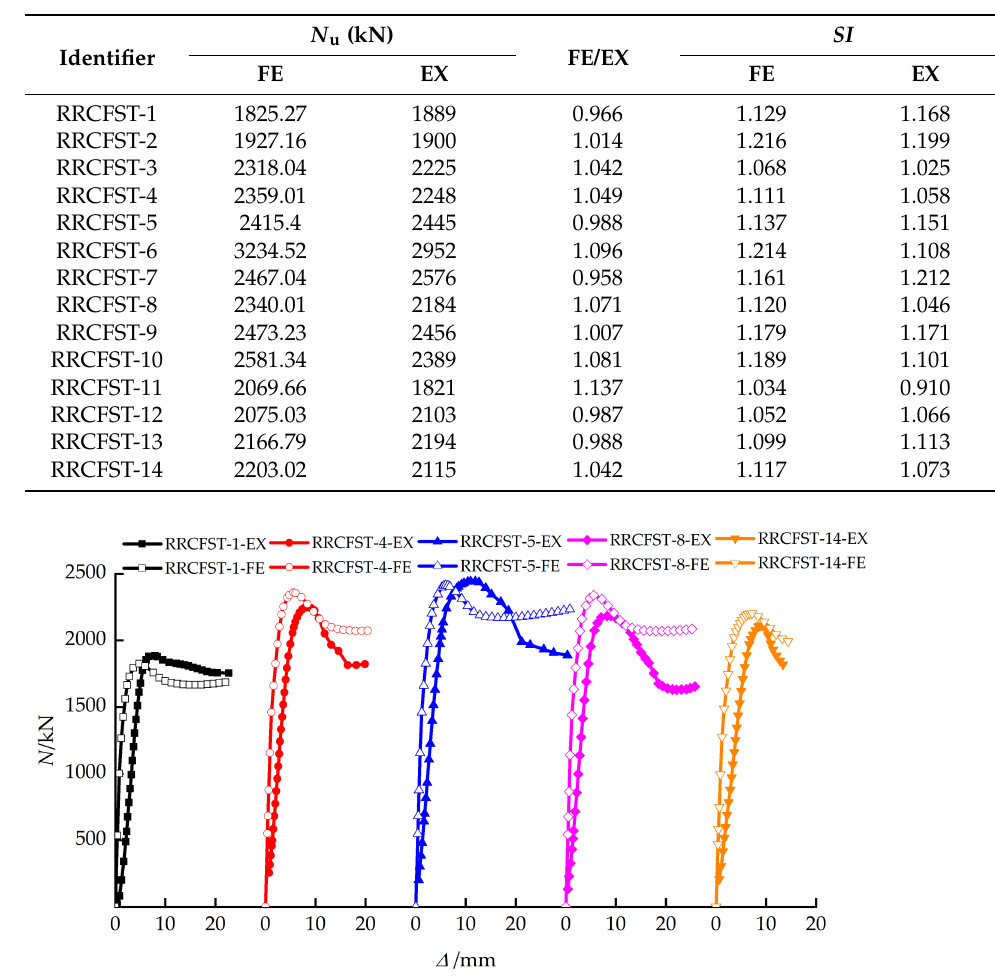
Figure 6. Comparison of load curves for part of the test column by FE analysis and the